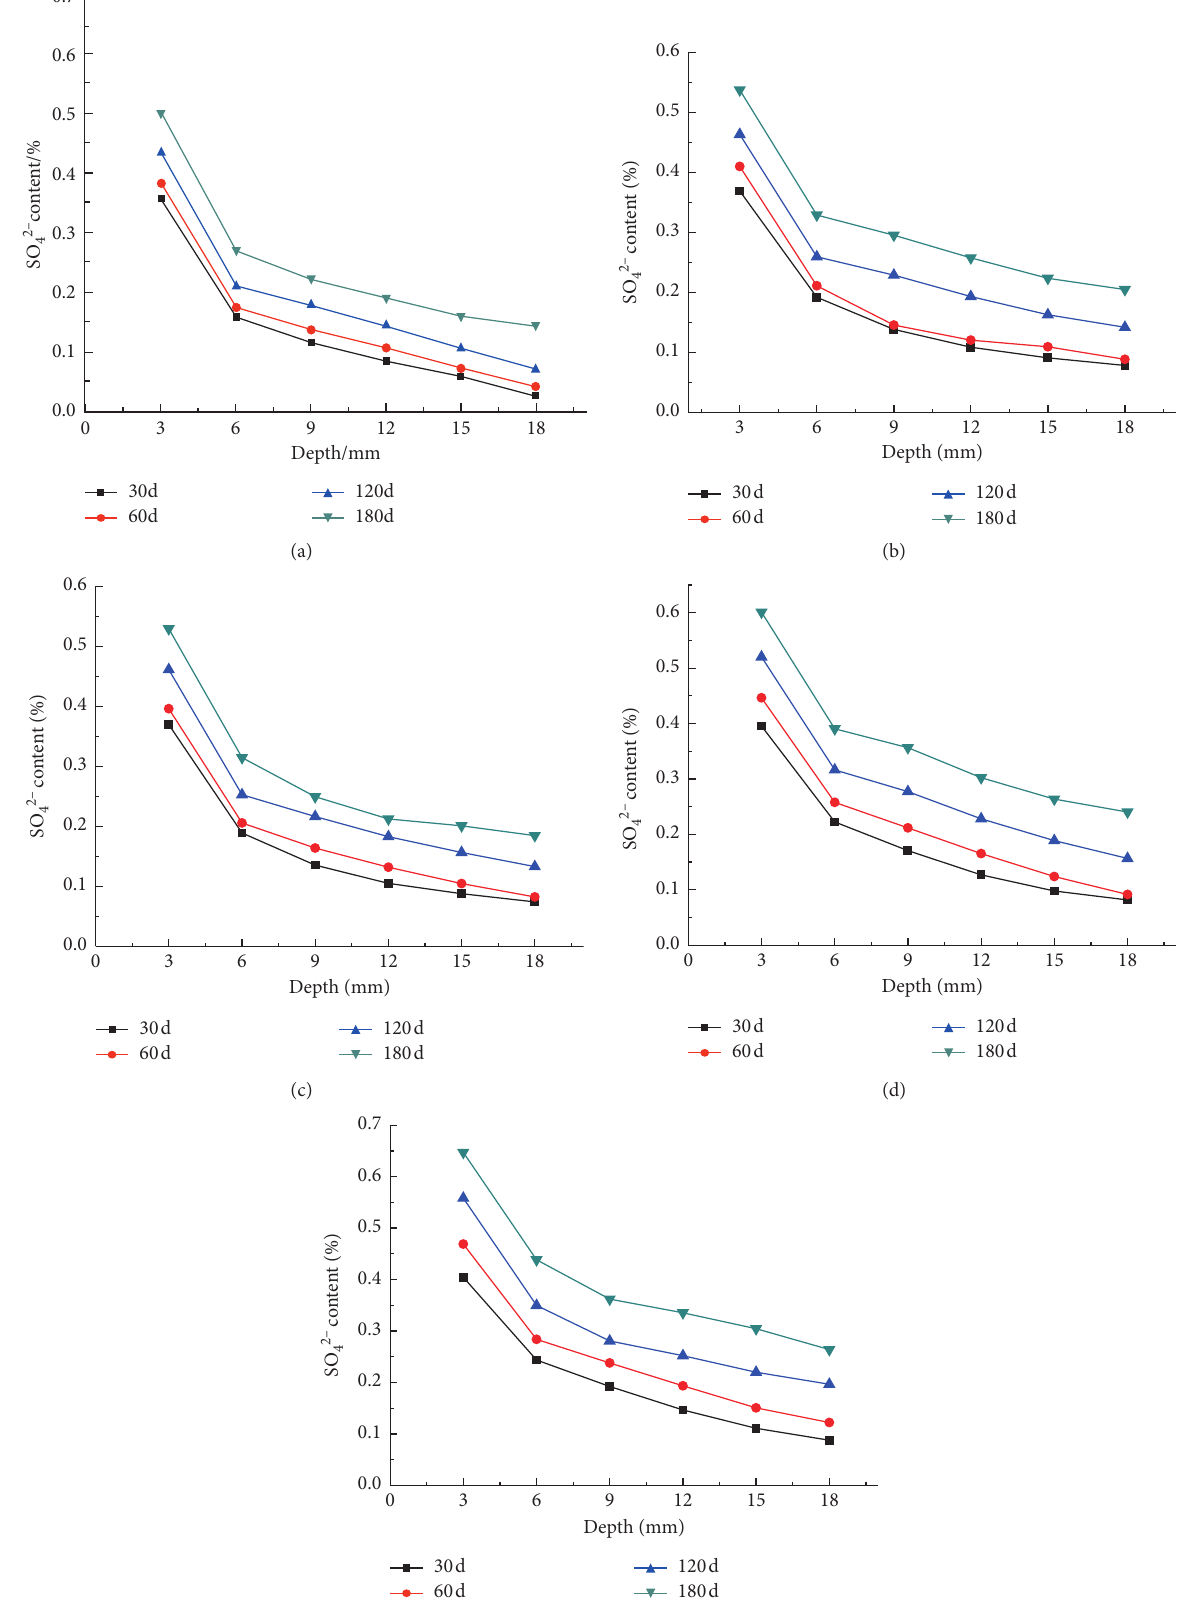
Figure 3: The relationship between SO 2 − concentration and immersion time at different diffusion depths. (a) 5% Na 2 SO 4 +3% MgSO 4 , (b) 5% 4 Na 2 SO 4 +5% MgSO 4 , (c) 5% Na 2 SO 4 +3% NaHCO 3 , (d) 5% Na 2 SO 4 +5% NaHCO 3 , and (e) 5% Na 2 SO 4 +5% MgSO 4 +5% NaHCO 3